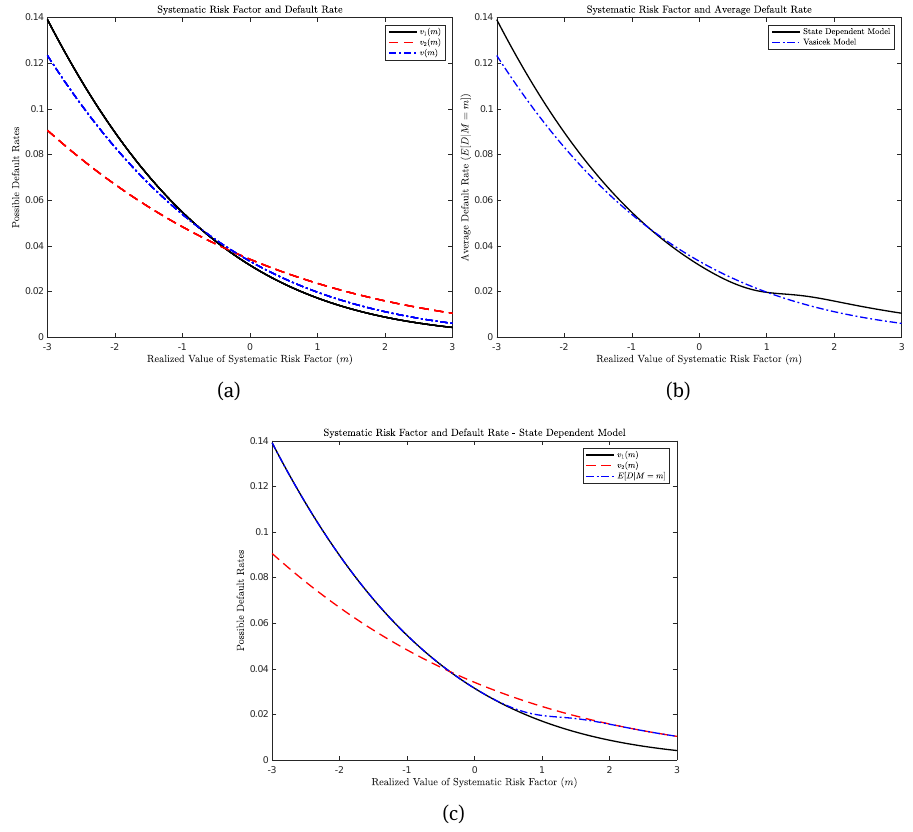
Figure 4.3: Panel (a) illustrates the curves v 1 (·) (solid line), v 2 (·) (dashed line) and v (·) (dash-dot line) in our numerical